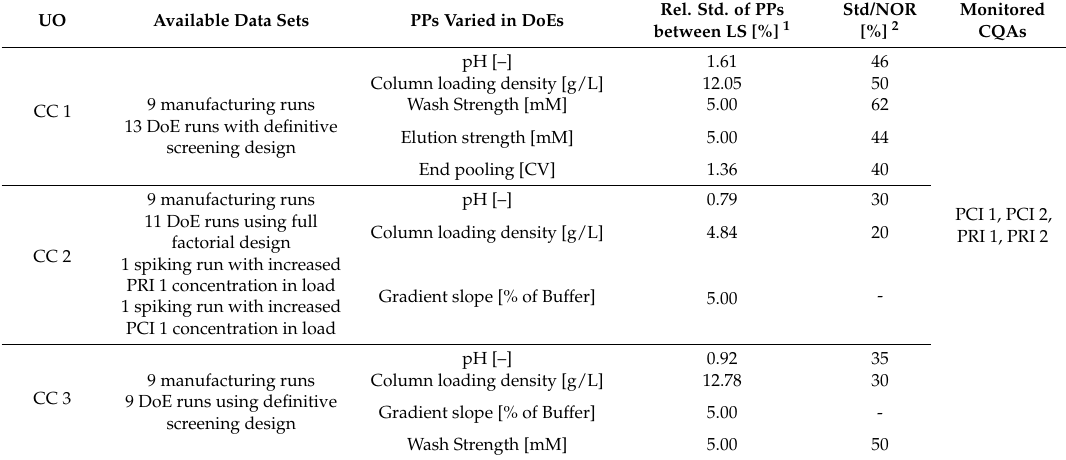
Table 1. Available data sets, process parameters, and monitored critical quality attributes (CQAs) for each unit operation included in the integrated process model (IPM). CC is abbreviation for chromatography column, PCI stands for process-related impurities and PRI product-related impurities. UO Available Data